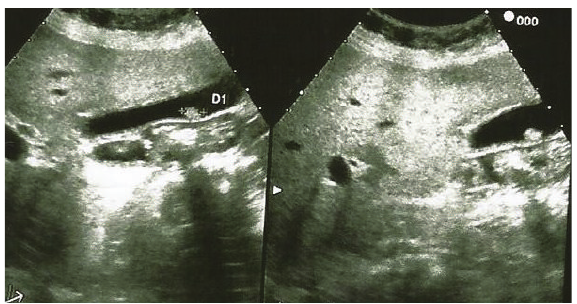
Figure 1: Image of polypoid mass attached to the gallbladder wall not showing acoustic shadow.